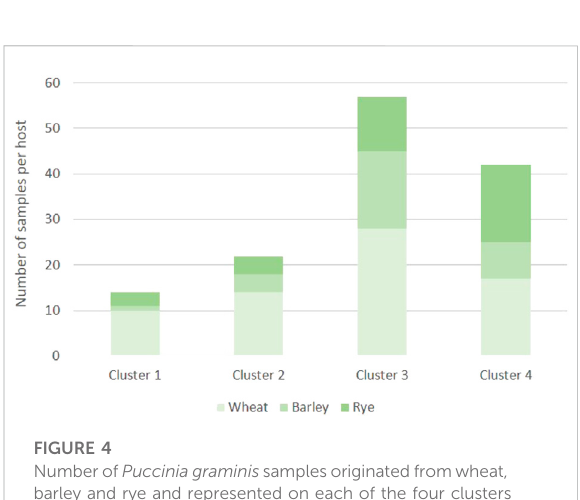
FIGURE 4 Numberof Pucciniagraminis samplesoriginatedfromwheat, barley and rye and represented on each of the four clusters identi fi ed in the DAPC